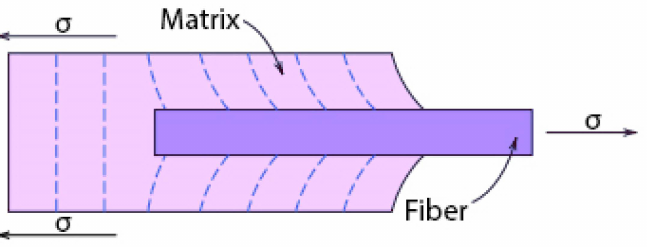
Figure 1. Classification of composite materials.